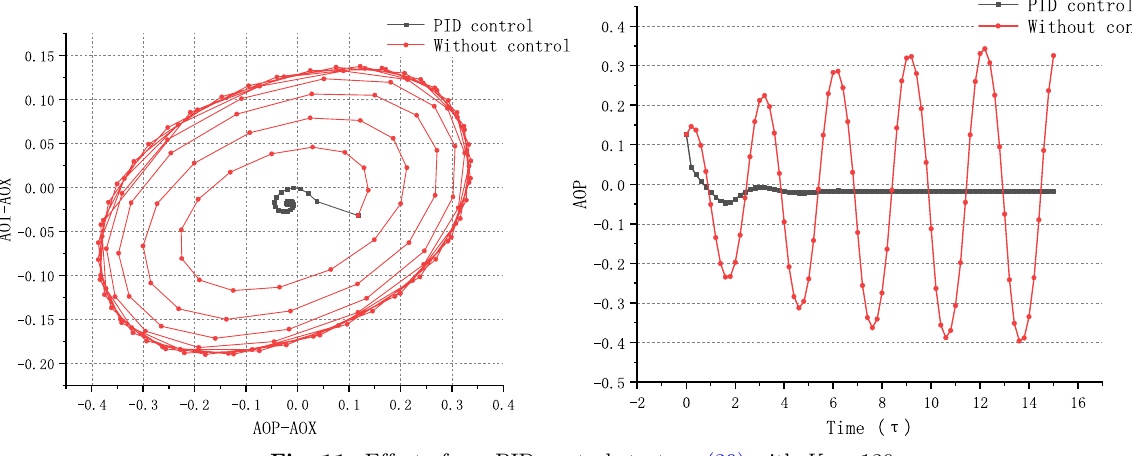
Fig. 11. Effect of our PID control strategy (39) with K d =